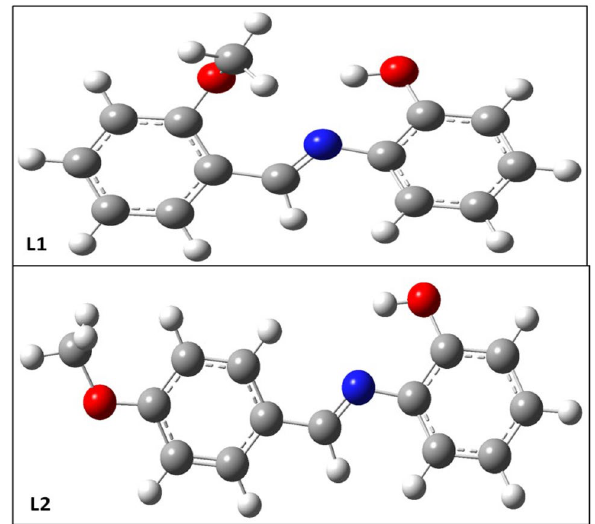
Figure 6. Optimized geometries of L1 and L2.